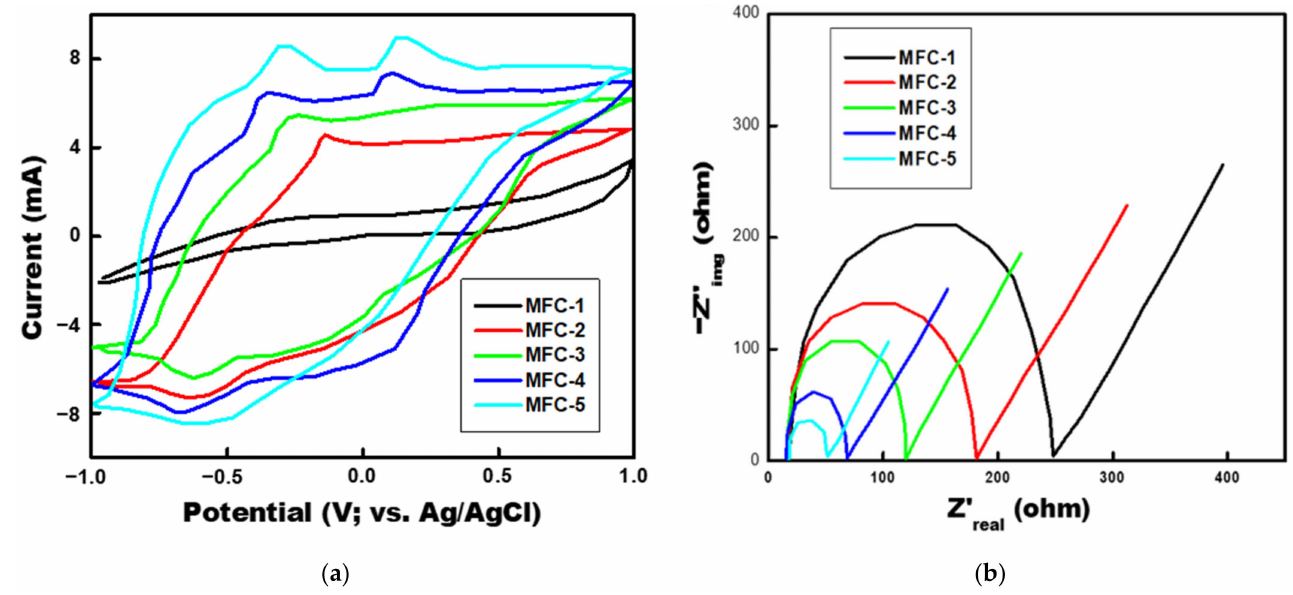
Figure 6. ( a ) Cyclic Voltammetry analysis of all five MFCs; ( b ) Nyquist plot of operational MFCs. The bandgap was determined from the ( α h ν ) 2 vs. h ν curve by drawing an extrapola- tion of the data point to the photon energy axis where ( α h ν ) 2 = 0, giving the optical band gap Eg. Figure 3 shows the energy bandgap (Eg) values for Fe 3 O 4 @PSA and Fe 3 O 4